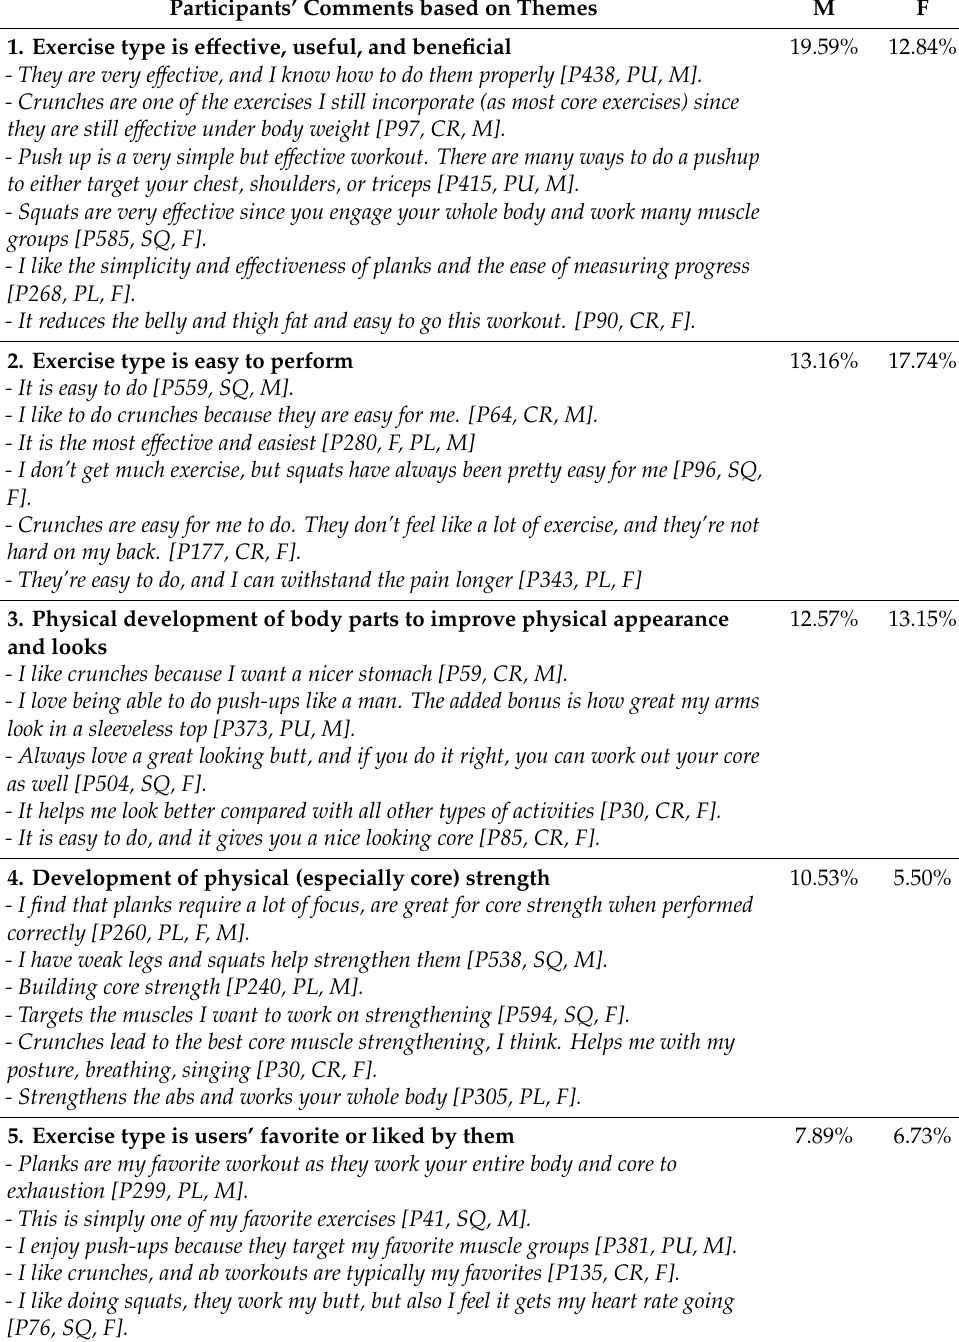
Table A1. Sample comments supporting teased-out drivers of users’ most preferred target exercise types. SQ = squat, CR = crunch, PL = plank, SP = side plank, CD = chair dip, LU = lunge, PU = push-up, PR = push-up and rotation, WS = wall sit, SU = step up, RIP = running in place, JJ = jumping jack, M = male, F =